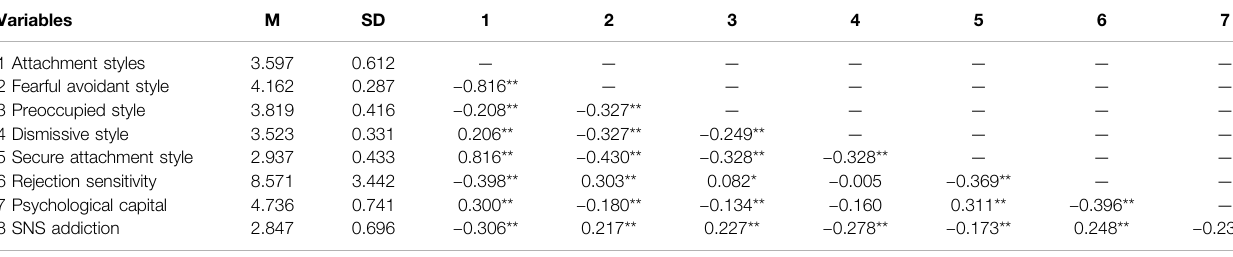
TABLE 1 | Descriptive statistics and results of correlational analysis of variables (N (cid:1) 607). Variables